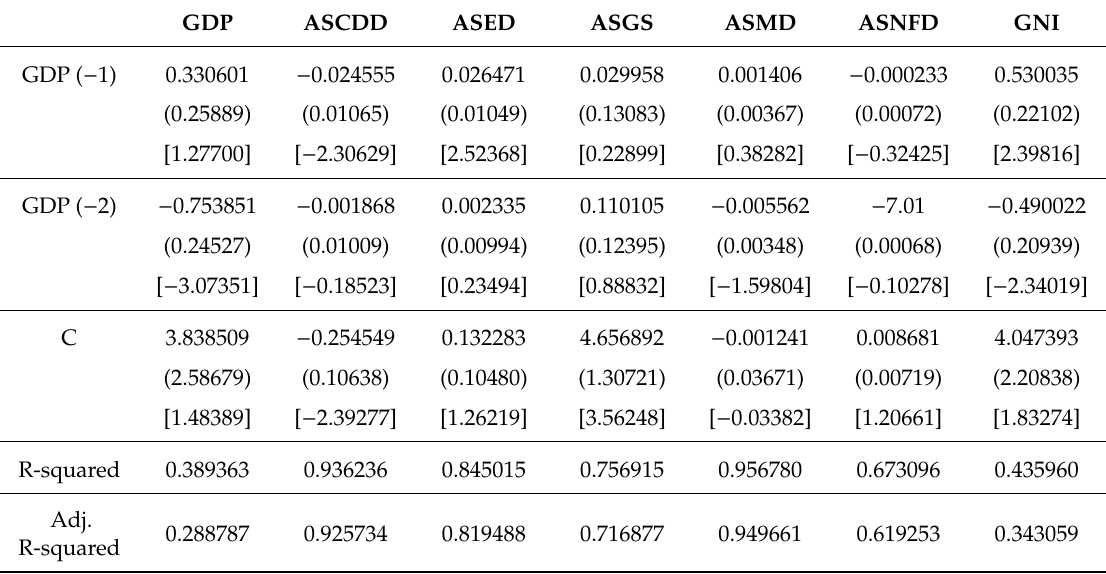
Table 5. Vector Autoregression Estimates.